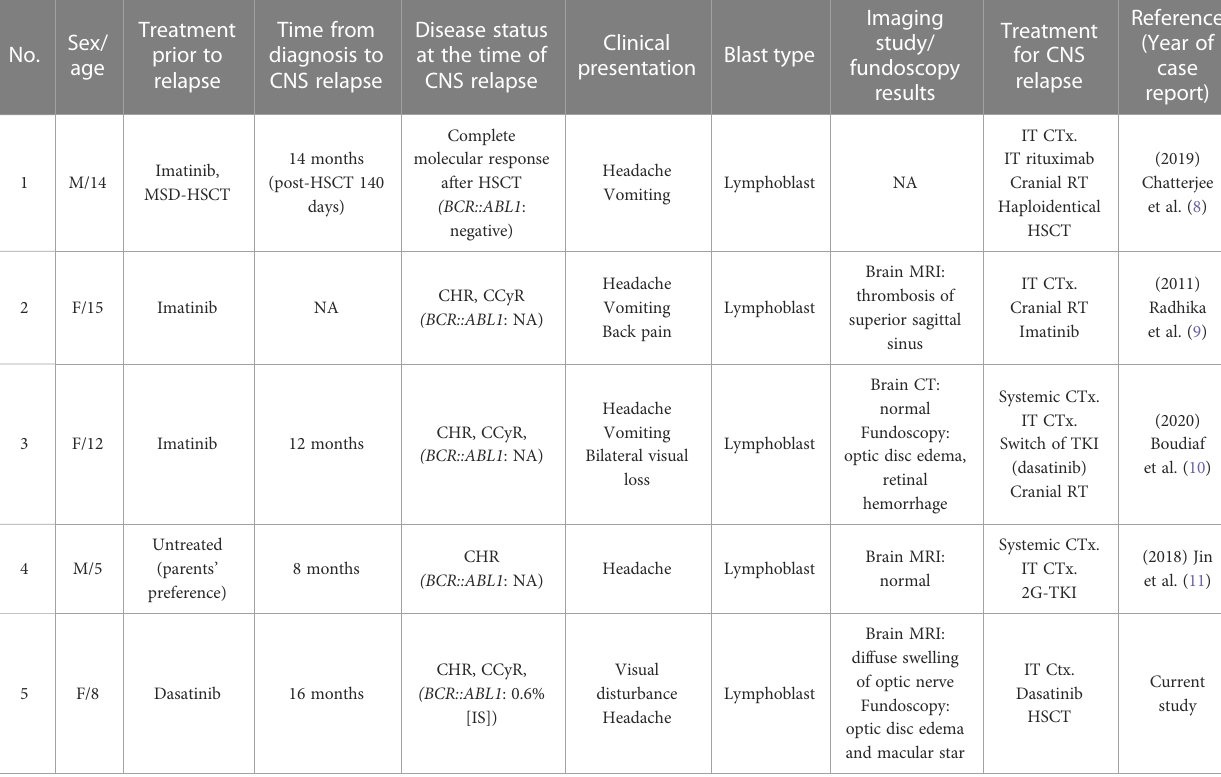
TABLE 2 Clinical details of reported cases of isolated CNS relapse in pediatric chronic myeloid leukemia.